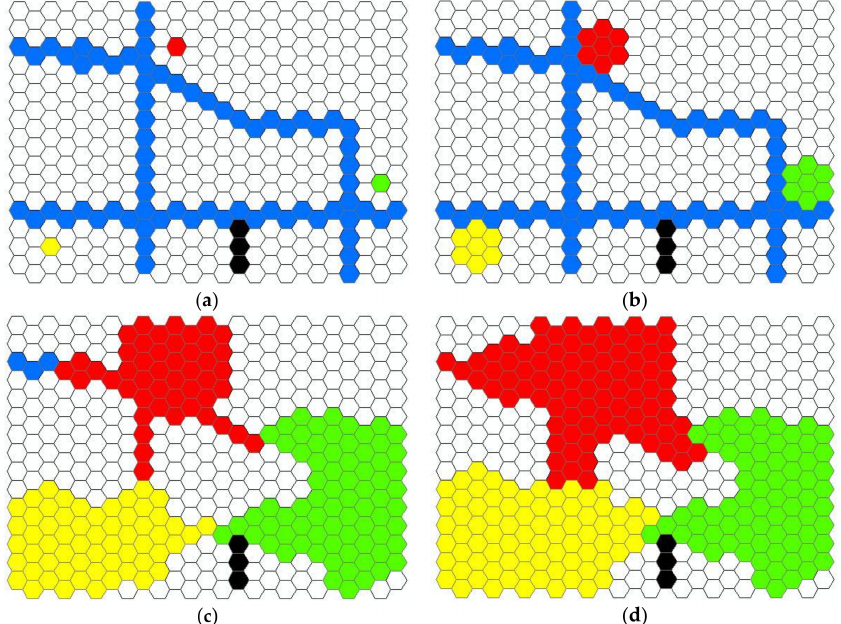
Figure 6. Illustration of the context-based crystal-growth activity space method. ( a ) The initial status with three seed cells; ( b ) crystal growth after one cycle; ( c ) crystal growth after several cycles; ( d ) the final result of crystal-growth. The red, yellow and green cells are three seed cells. Blue cells represent transport network, while black cells illustrate the physical barriers. The other white cells imply the walkable